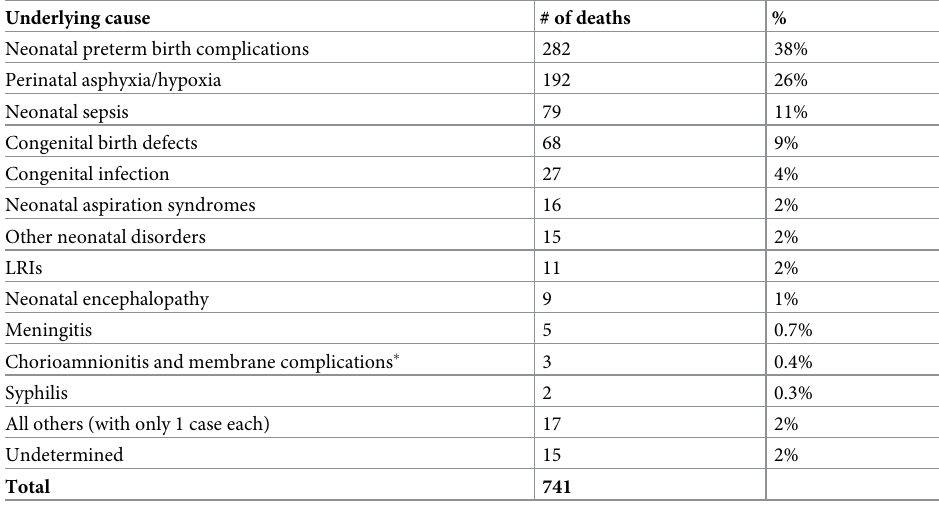
asphyxia (192, 26%), neonatal sepsis (79, 11%), and congenital birth defects (68, 9%). Exclud- ing 15 deaths for which the CoD was undetermined, 503 (69%) deaths had 1 or more CoD beyond the underlying cause (mean = 1.4, IQR 0 to 2). Preterm birth complications include low birth weight, respiratory distress syndrome, prematurity, and bronchopulmonary dyspla- sia; of those neonatal deaths with preterm birth complications listed anywhere in the causal chain, 67% (234/347) had respiratory distress syndrome. Among 282 neonatal deaths with preterm birth complications as the underlying condition, 256 (91%) had additional conditions in the causal chain, including 184 (65%) with another type of preterm birth complication (Table 5). Nearly half (137, 49%) of neonatal deaths with preterm birth complications as the underlying cause had other conditions not related to pre- term birth complications within the causal chain. Indeed, more than half of the deaths with preterm birth complications or congenital birth defects as underlying conditions had � 3 other diagnoses in the causal chain (Table 5). The most common conditions listed as immediate or antecedent causes (other than preterm birth complications) included neonatal sepsis [128 (45%)], LRI [69 (24%)], meningitis [60 (21%)], and perinatal asphyxia/hypoxia [25 (9%)] (Table 6). When known, the most common maternal factors associated with deaths due to pre- term birth complications included hypertension (58/273, 21%), multiple gestation (39/273, 14%), and placental separation/antepartum hemorrhage (26/273, 10%). For deaths due to peri- natal asphyxia, the most common maternal factors included obstructed labor and other com- plications of labor and delivery and placental separation/antepartum hemorrhage.